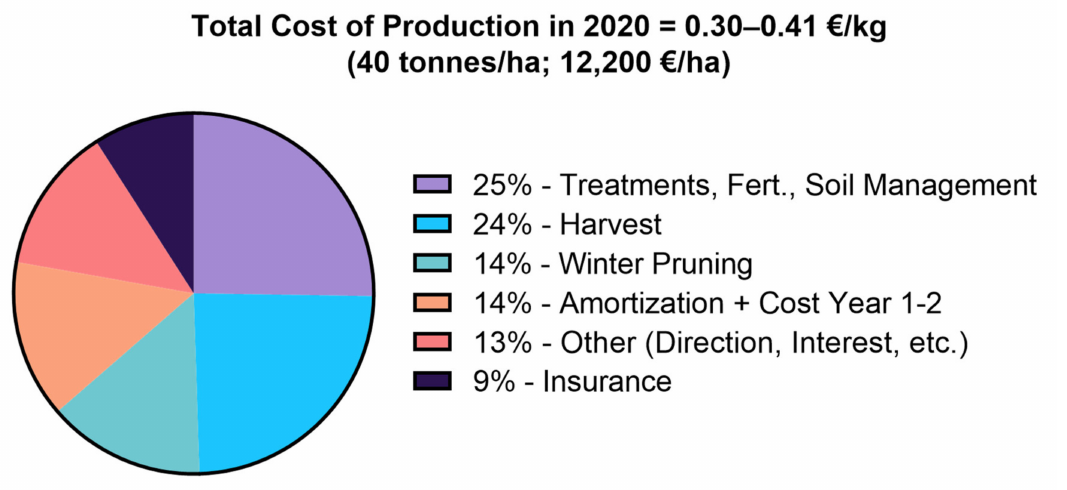
Figure 2. Cost of production corresponding to Conference (0.30 € /kg) and Abb é F é tel (0.41 € /kg) pear cultivars in a traditional orchard trained in bi-axis in the Ebro Valley,